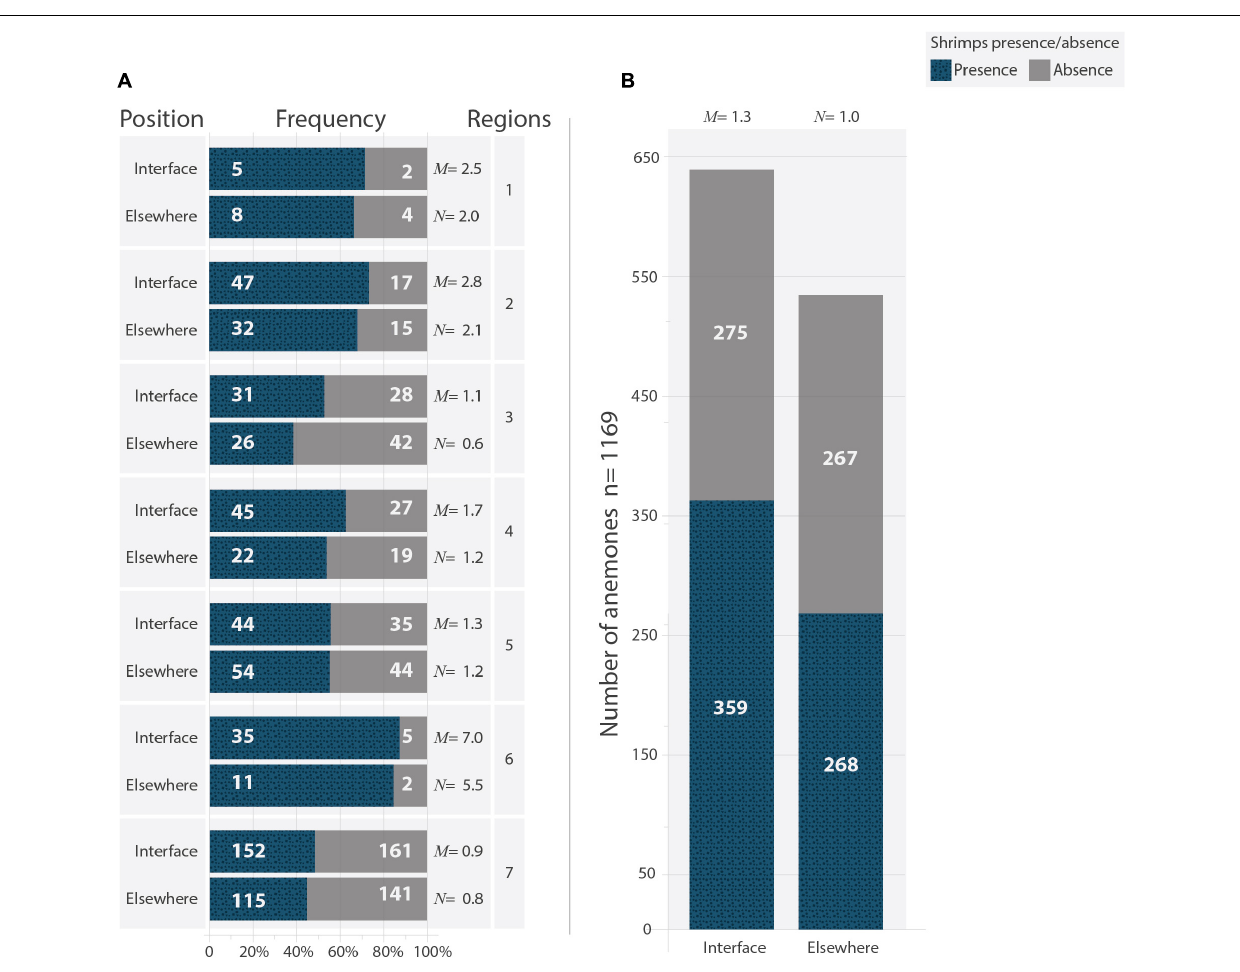
FIGURE 5 | Occurrence of Bartholomea annulata in the interface between hard substrates and the sandy bottom (Interface) or other microhabitats (Elsewhere), and were associated with at least one (blue) or without (gray) A. armatus complex. (A) Relative frequency in seven regions off the Mexican Caribbean coast of Quintana Roo. (B) Absolute frequency of pooled data of all seven regions. The odds of finding a B. annulata with at least one Alpheus shrimp in the interface ( M ) and elsewhere ( N ) are given for each region and for the pooled data. The numbers of anemones falling in each of the four categories is also